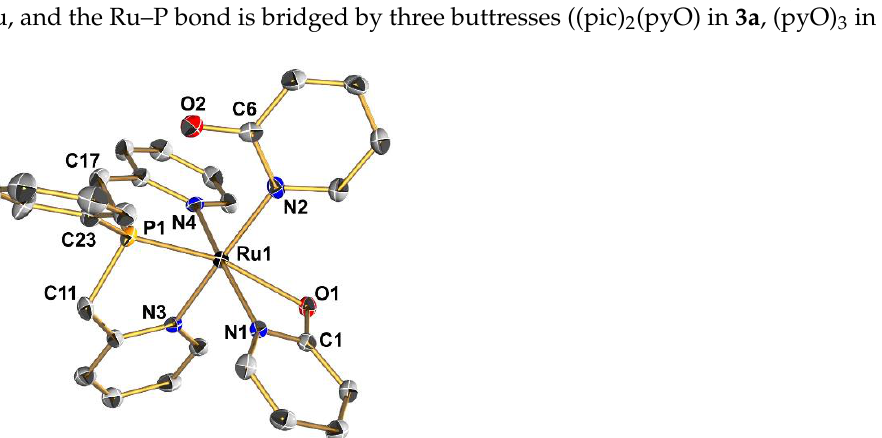
Figure 1. Molecular structure of 3a in the crystal (thermal displacement ellipsoids drawn at the 50% probability level, selected atoms labeled, H-atoms are omitted for clarity). The asymmetric unit consists of two molecules of 3a in very similar conformation; thus, only one of them is shown as a representative example. Selected interatomic distances (Å) and angles (deg.) of 3a :